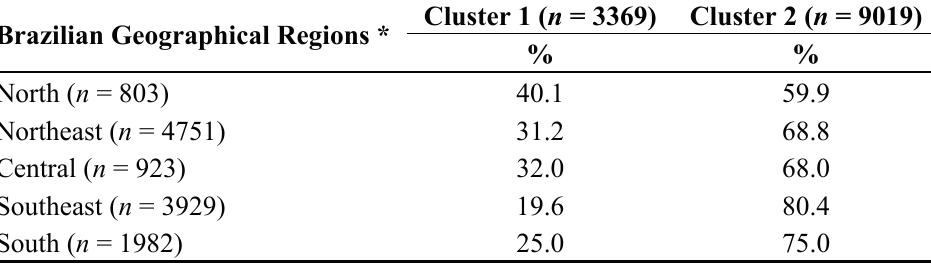
Table 5. Proportion of the two clusters according to Brazilian geographical region in